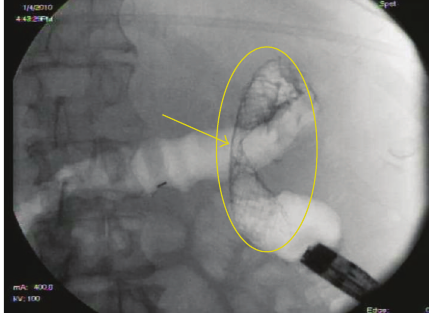
Figure 4: Fluoroscopic view after colonic stent placement (yellow oval).